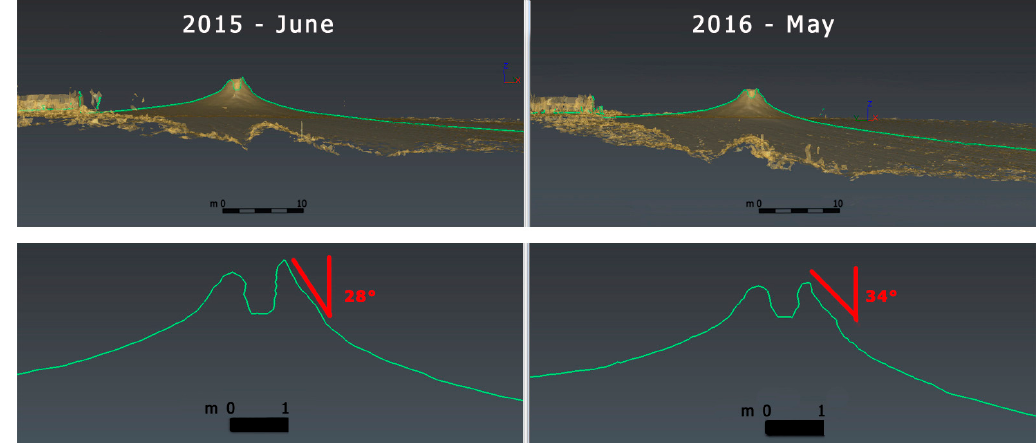
Figure 6. Measurement of the angular variations of one of the main cone of the Niranofield (located in the Area 3) by digitization of laser scanning point cloud.